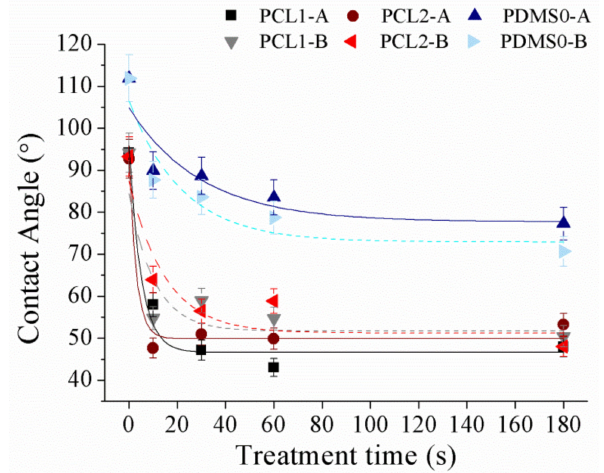
Figure 4. The water contact angle of PCL and PDMS films after being treated with O 2 at different parameter